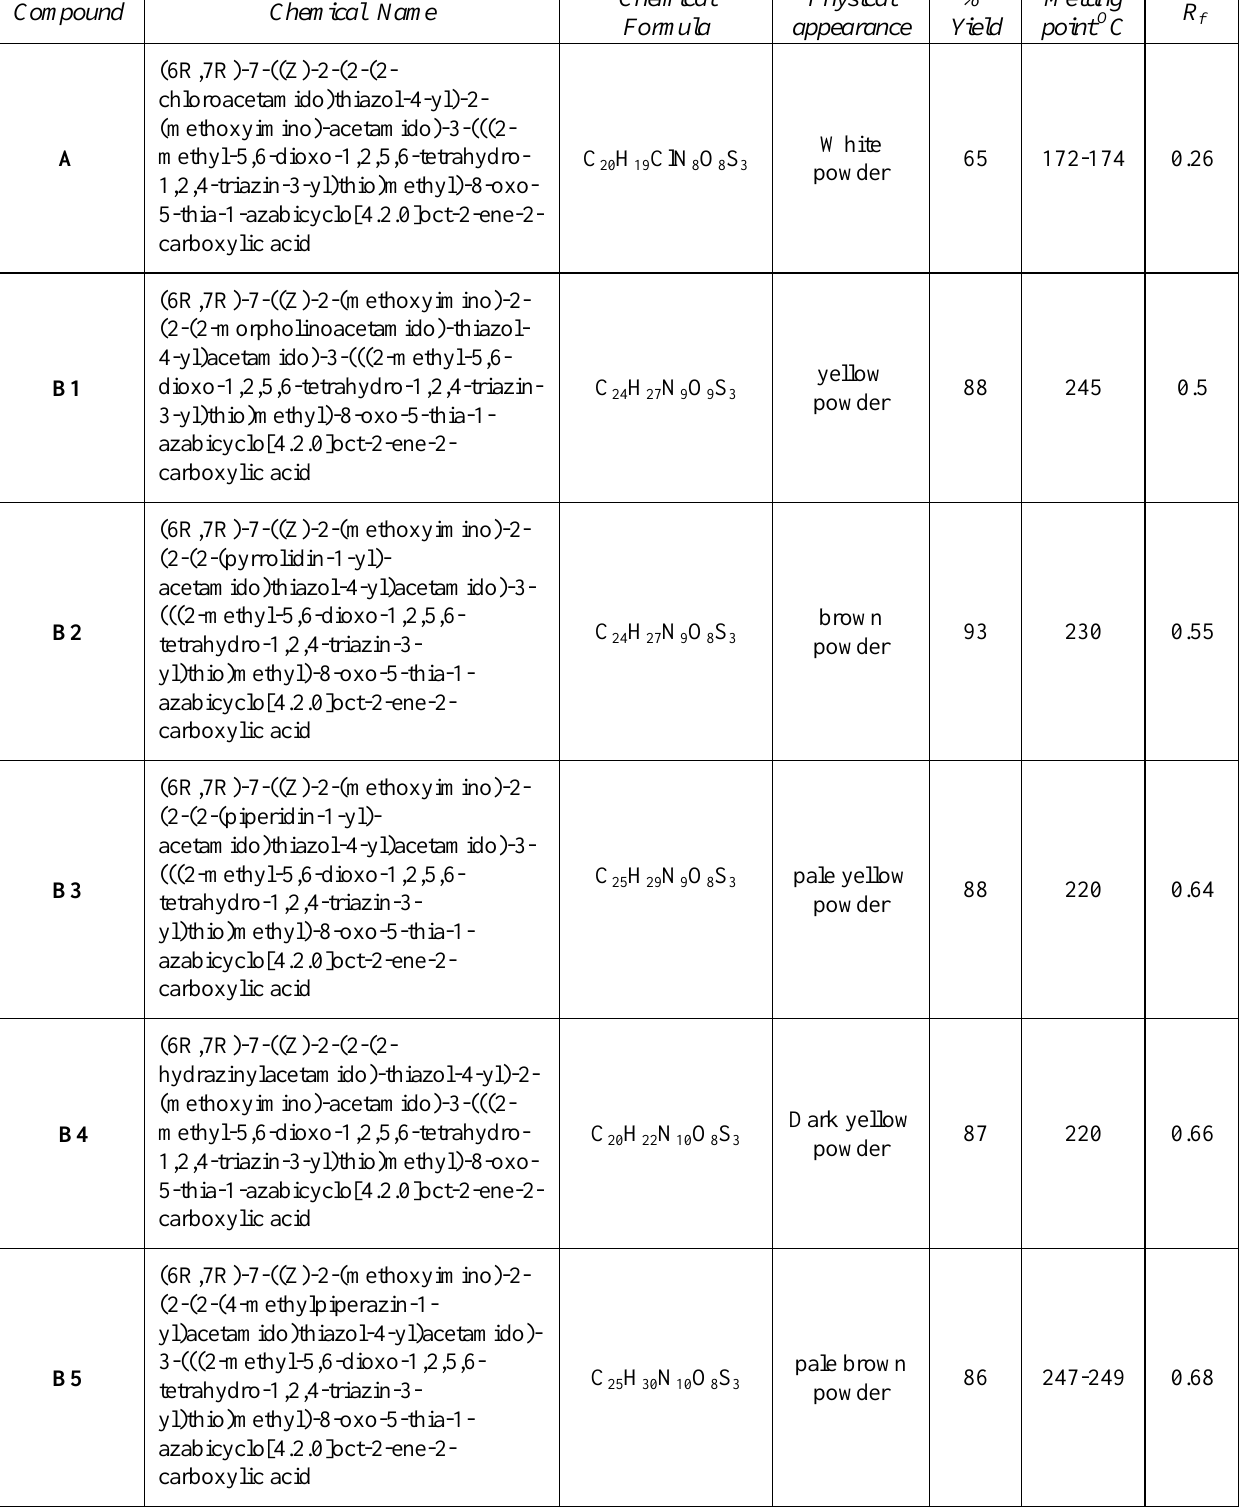
Table( 1): The percent yield, physical appearance, uncorrected Melting points, and R the synthesized intermediate (A) and target compounds